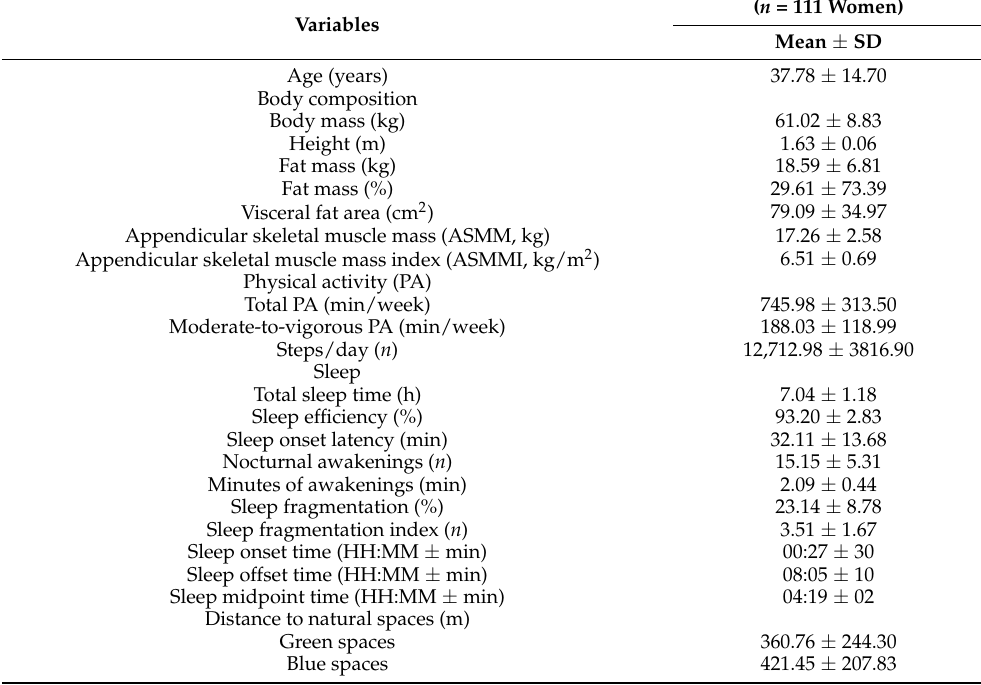
Table 1. Baseline characteristics of study participants.